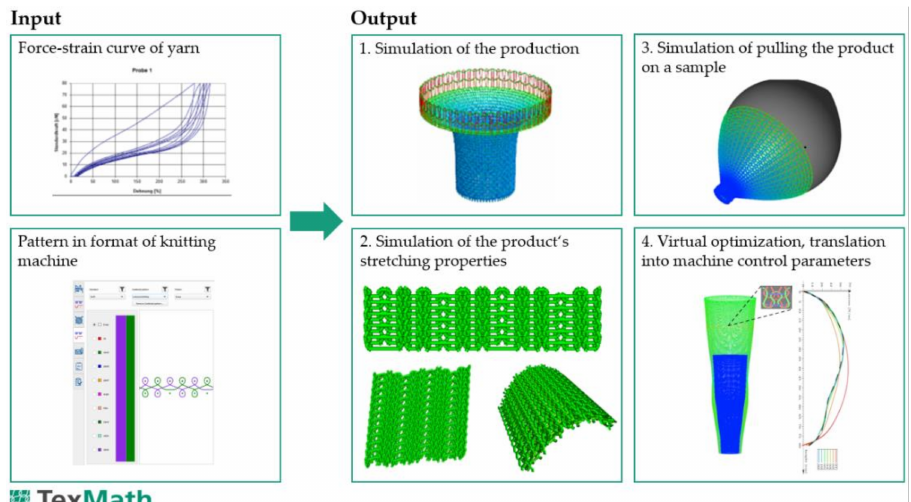
Figure 19. Design optimization loop from the knitting machine to the knitting fabrics with desired properties.